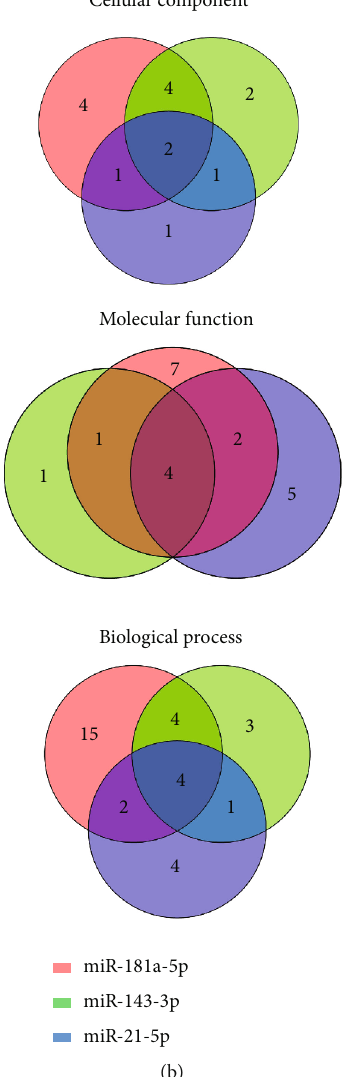
Figure 3: Enriched GO terms of predicted targets of di ff erentially expressed miRNAs. (a) The stacked chart shows signi fi cantly enriched GO terms (cellular component, molecular function, and biological process) of predicted targets of miR-181a-5p, miR-143-3p, and miR-21-5p. The gene count indicates the number of target genes that related to each GO term. (b) The Venn graph to show numbers of common GO terms enriched for predicted targets of miR-181a-5p, miR-143-3p, and miR-21-5p. The names of the common GO terms can be checked out in